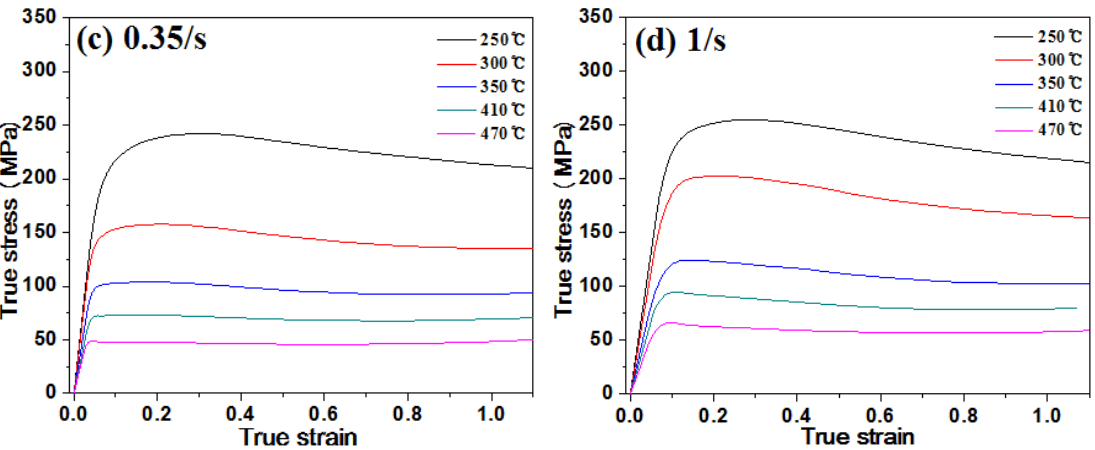
Figure 6. True stress ‐ true strain curves of the specimens compressed at various temperatures under a strain rate of ( a ) 0.001/s; ( b ) 0.0035/s; ( c ) 0.35/s; ( d ) 1/s.